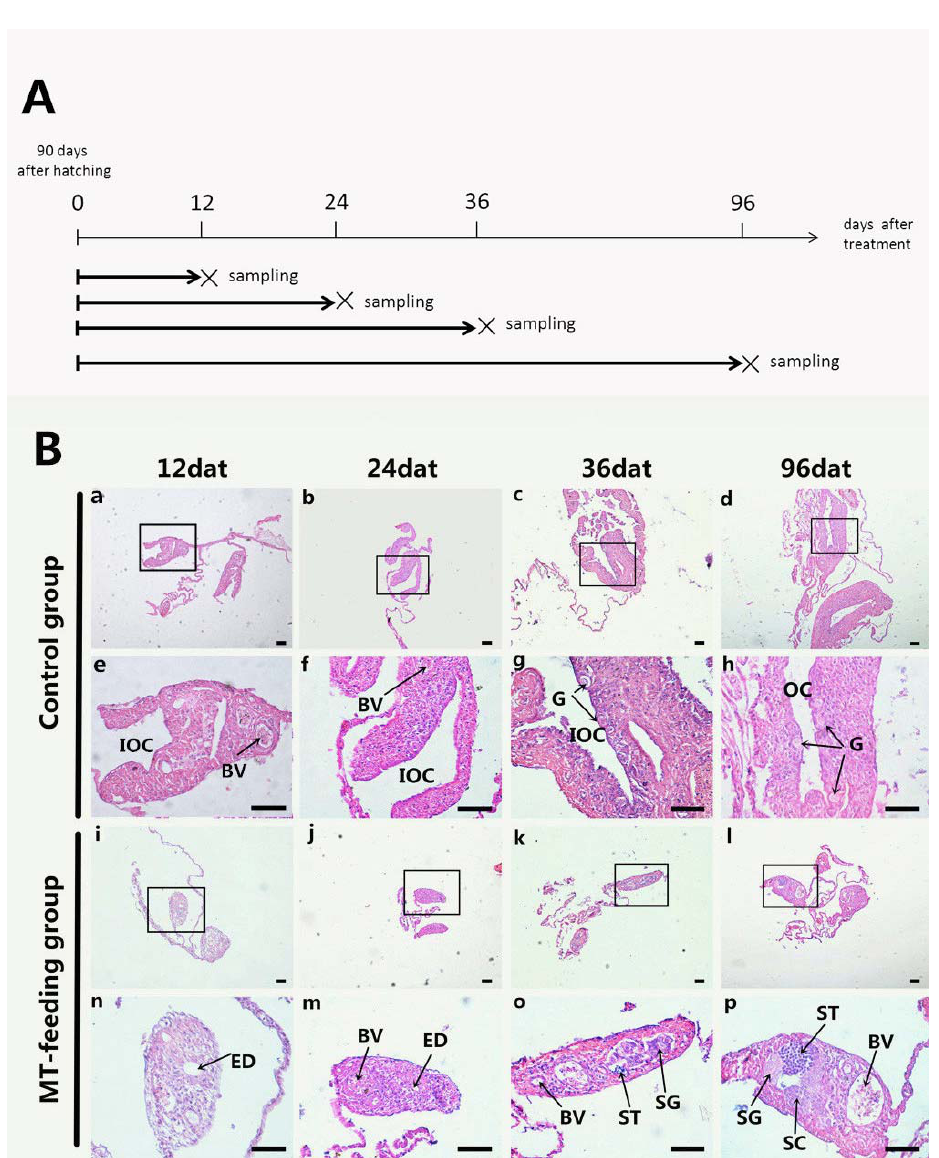
Figure 1. Gonad histology analysis during methyltestosterone (MT)-induced sex reversal. ( A ) Sampling time points. ( B ) Gonad histology. a–h: Gonad histology of control fish; i–p: Gonad histology